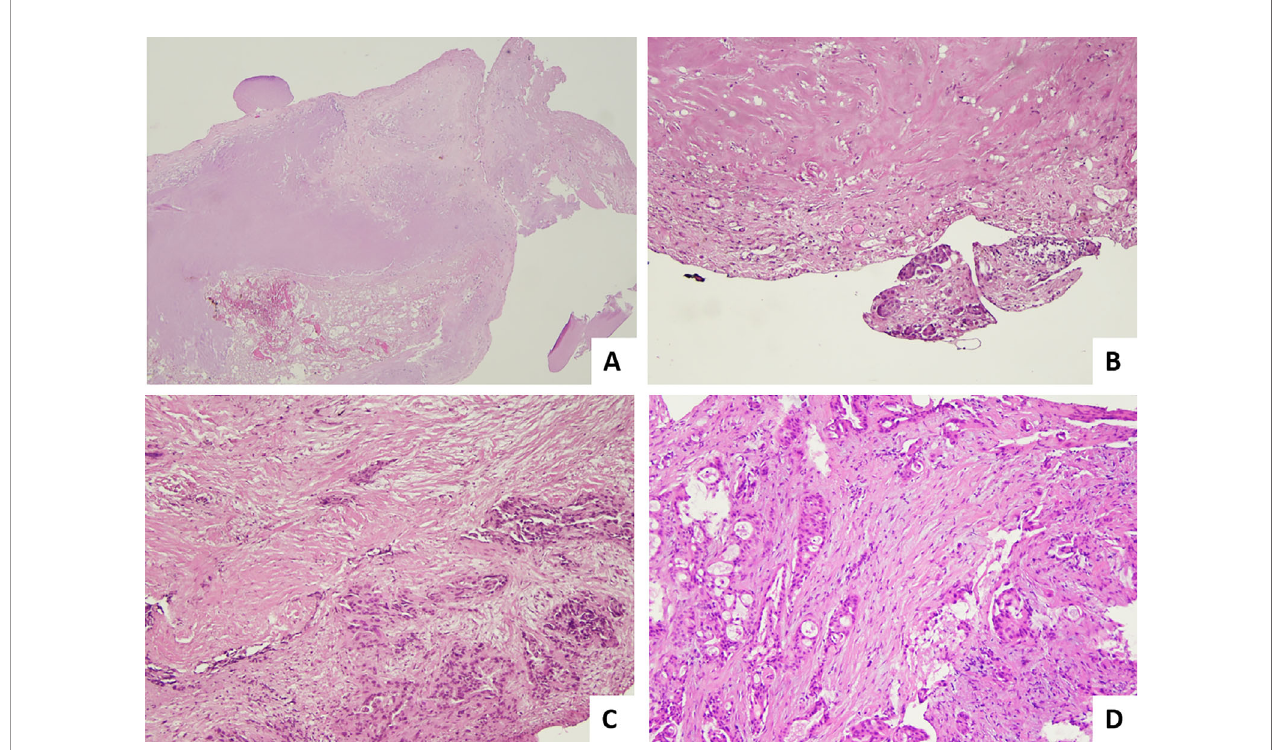
FIGURE 2 | Pathological response score for post-PIPAC peritoneal metastasis. (A) Example of PRGS1 or complete response: regressive sclero-necrotic changes without evidence of residual tumor cells (H&E; 2×). (B) Example of PRGS2 or major response; regressive sclerotic changes predominant over few aggregates of residual tumor cells (H&E; 20×). (C) Another area of the case illustrated in B (PRGS2) (H&E; 4×). (D) Example of PRGS3 or minor response: tumor cells predominant over regressive fi brotic changes (H&E;